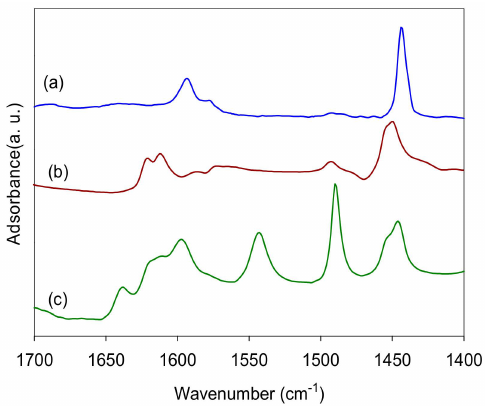
Figure 8. Pyridine-FTIR under 10 − 3 torr at 200 ◦ C over ( a ) Pt / (HZSM-48 + pseudoboehmite,1:1) ( b ) pseudoboehmite, ( c ) Pt / HZSM-48.